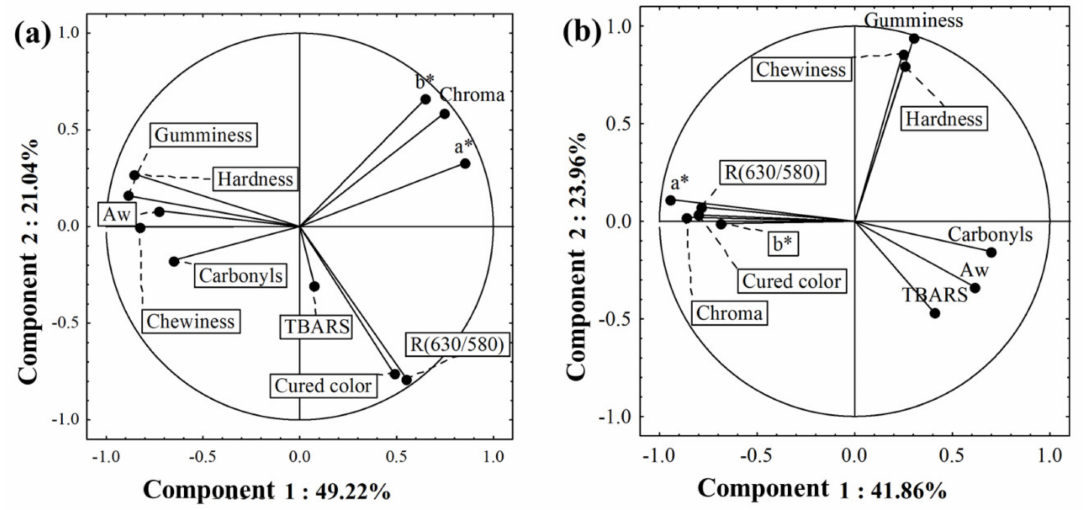
Figure 2. Principal component analysis of the significant variables ( p < 0.05) in cluster 1 (LWA, low water activity) ( a ) and cluster 2 (HWA, high water activity) ( b